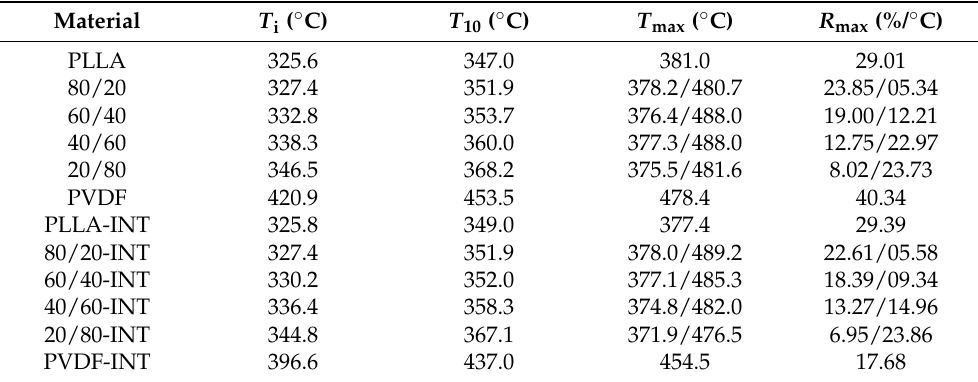
Table 1. TGA parameters of different PLLA/PVDF/INT-WS 2 blend nanocomposites based on PLLA, PVDF, and INT-WS 2